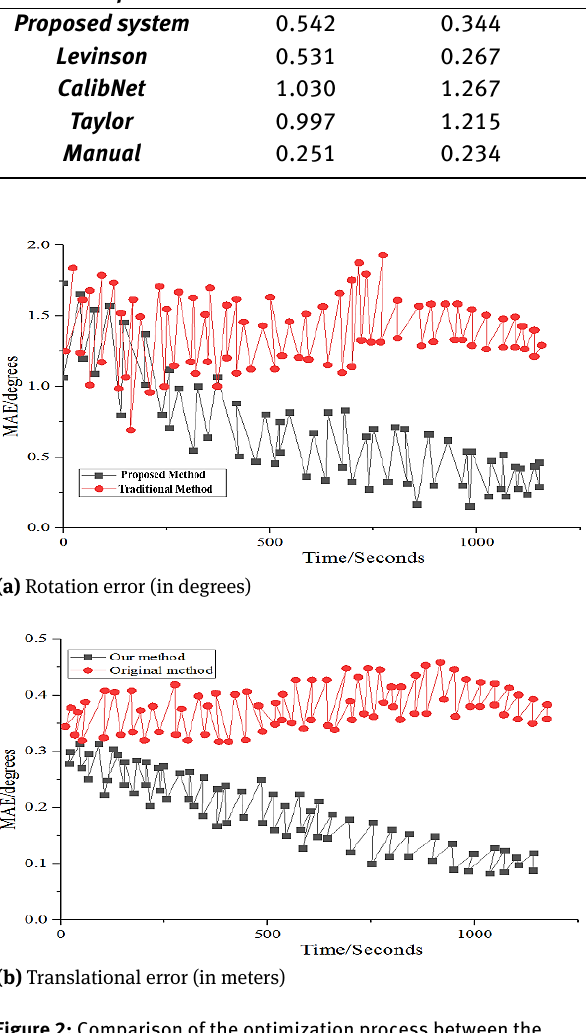
Table 1: Comparison of the results of the representative algorithms of various techniques Techniques